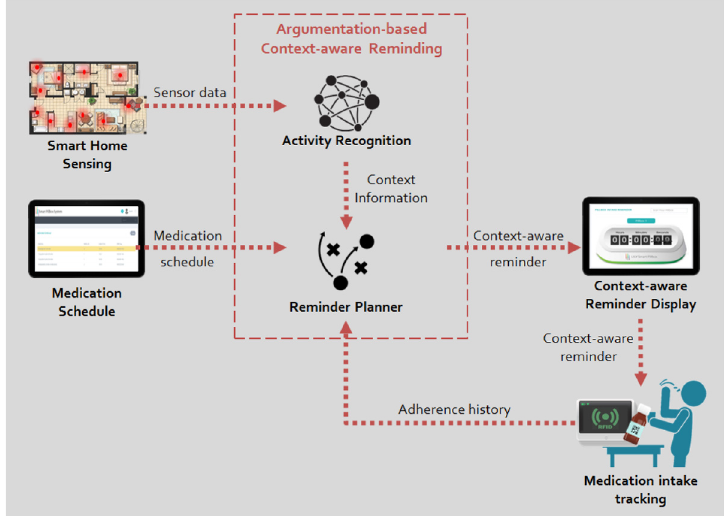
framework of the smart pillbox